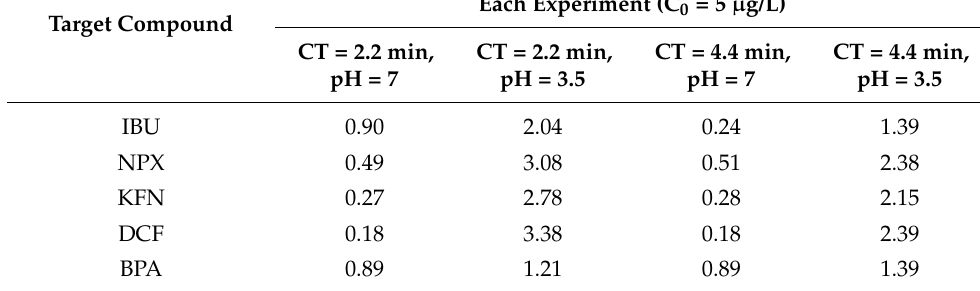
Table 6. The ratio of mass of pollutant removed per mass of the nanocomposite material (R-nFe) at the end of each experiment, with and without pH adjustment to 3.5 for the contact times of 2.2 min and 4.4 min (initial concentration of each pollutant, 5 µ